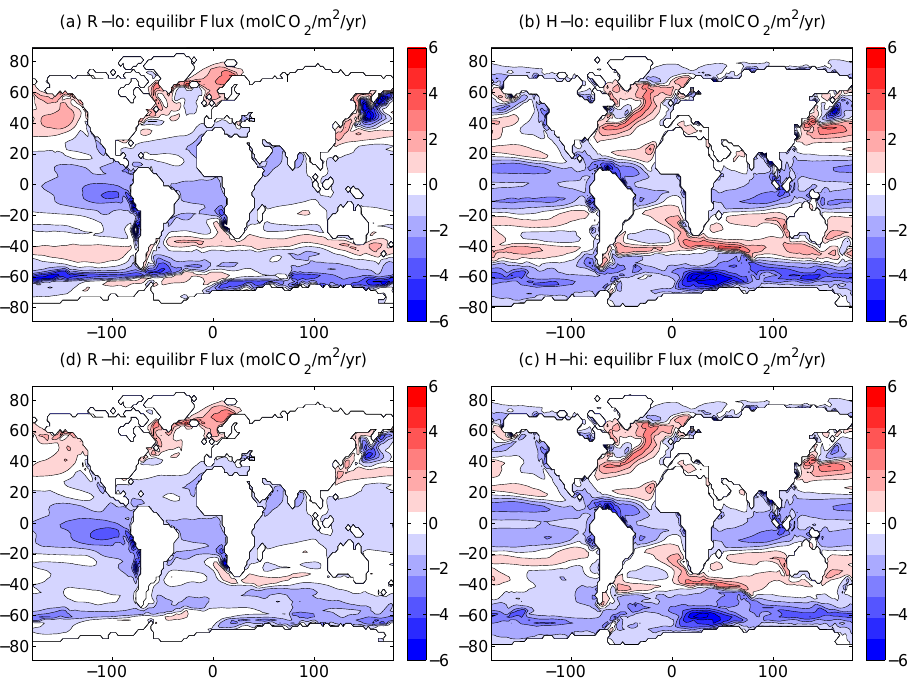
Fig. 13. Equilibrium flux (molCO 2 m − 2 yr − 1 ). Red denotes uptake, blue denotes outgassing. In unshaded regions the flux is low. These are results from the two models GISSER and GISSEH using different remineralization scales. Hi refers to high remineralization rate (i.e., fast recycling of nutrients) and lo refers to low remineralization rate.